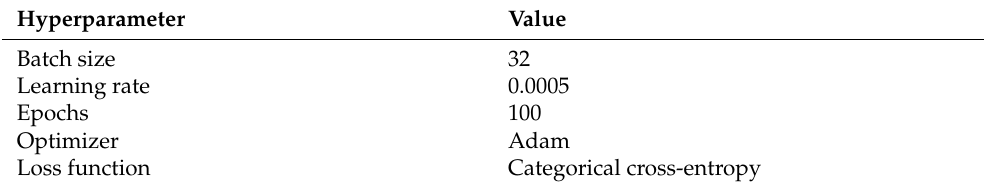
Table 4. Illustration of hyperparameter setting used in this study.